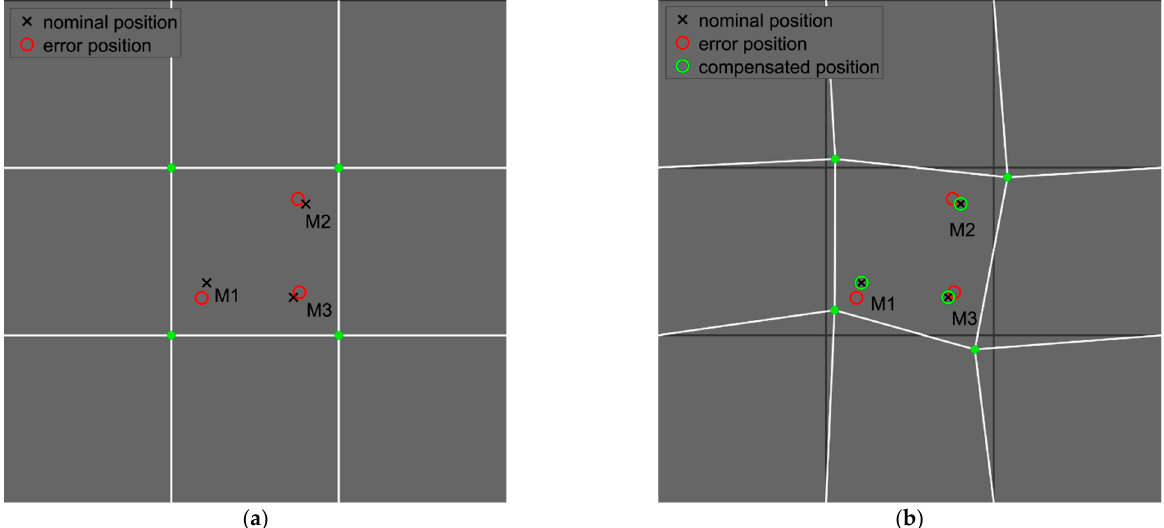
Figure 7. Numeric simulation of correction mesh calculation: ( a ) nominal position with an arbitrary error at every point; ( b ) compensated position evaluated from the correction mesh. Three measured points with position deviations were positioned in the middle cell.